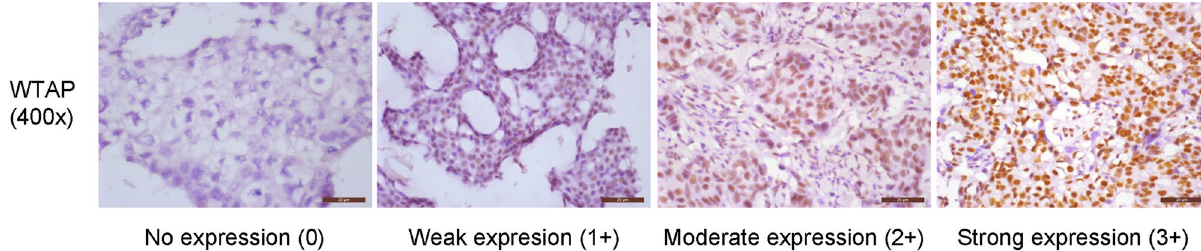
Figure 1. WTAP expression levels in breast cancer patients. Breast cancer tissue specimens were immune- stained with anti-WTAP antibody, photographed using an optical microscope and scored from 0 (negative) to 3 (strong) for nuclear staining intensity of WTAP expression.